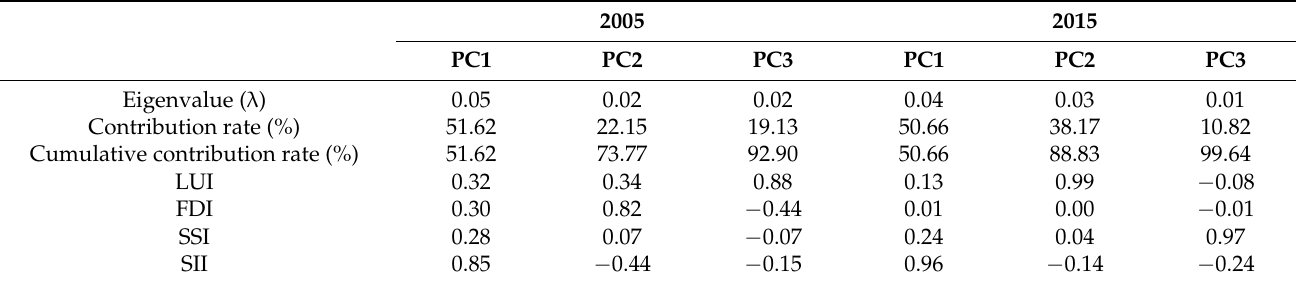
Table A2. Eigenvalues and correlation coefficient matrix of principal components of pressure indicators in 2005 and 2015.